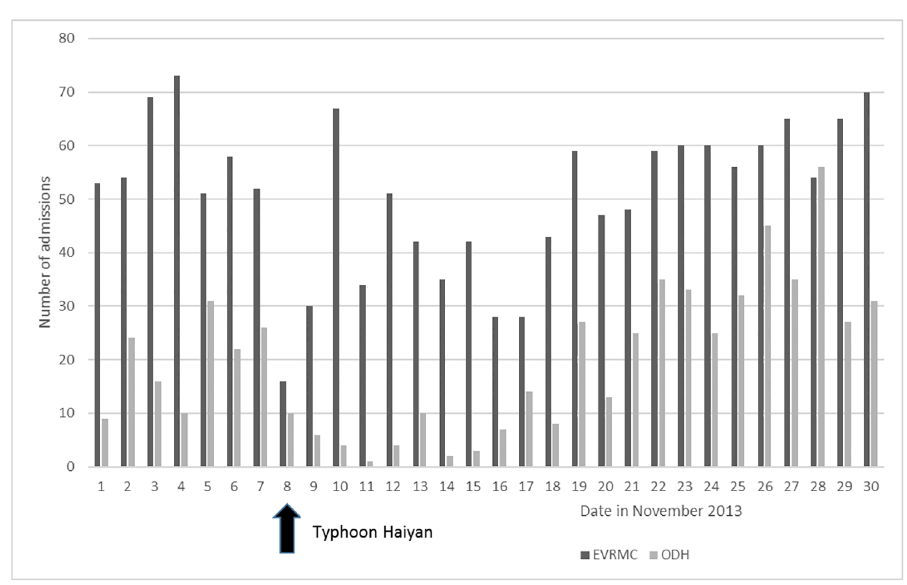
Fig 2. Number of daily hospital admissions before and after Typhoon Haiyan (November 2013) for Eastern Visayas Regional Medical Center (EVRMC) and Ormoc District Hospital (ODH).